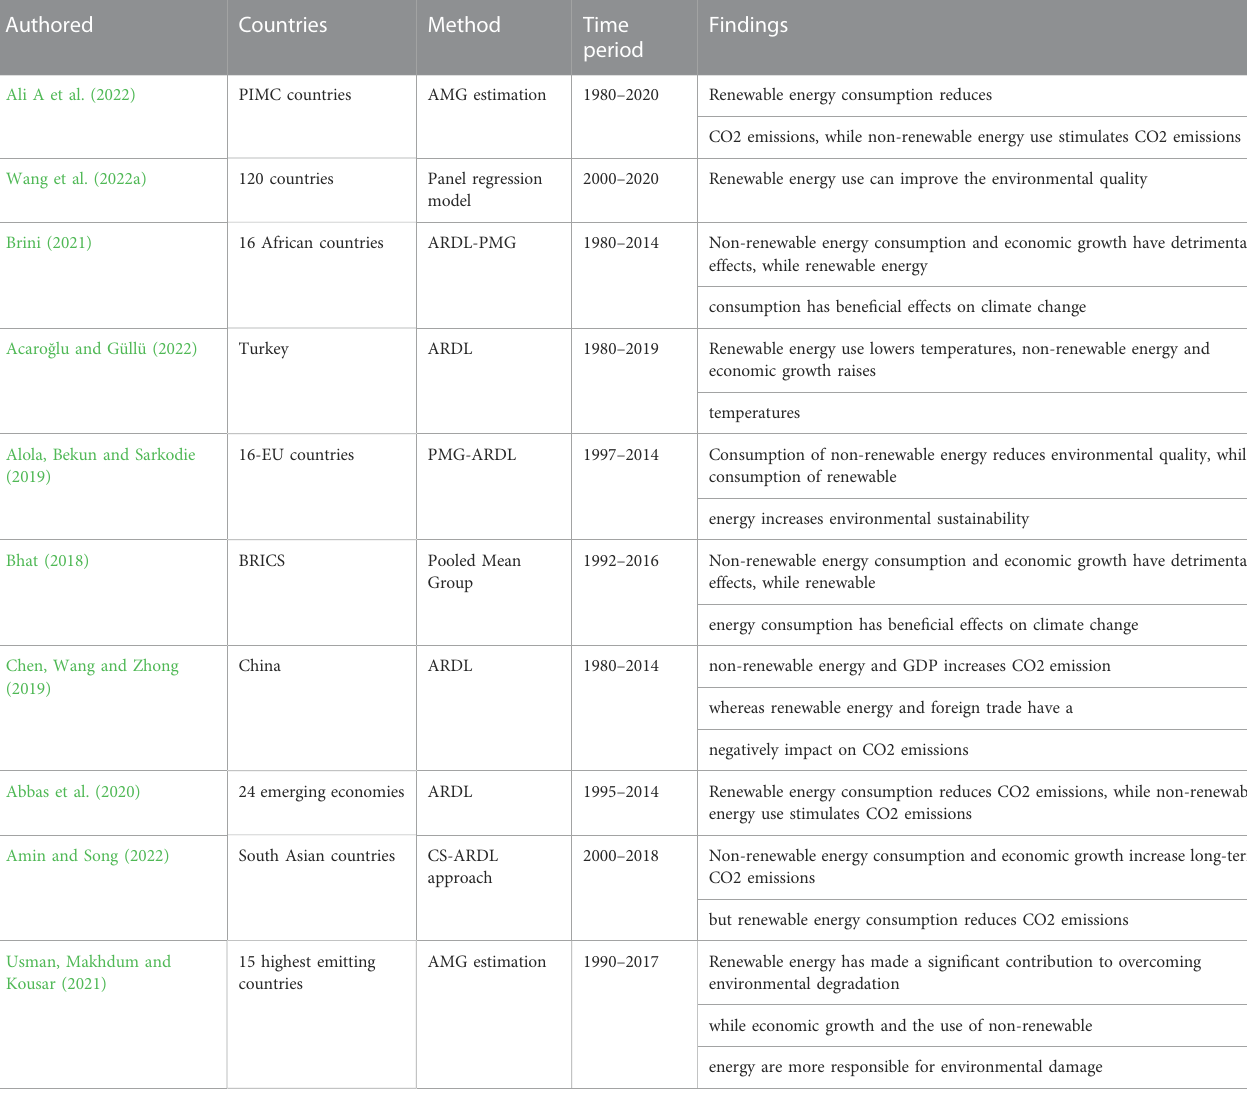
TABLE 1 Summary literature of the impact of renewable and non-renewable energy consumption and economic growth on climate change.